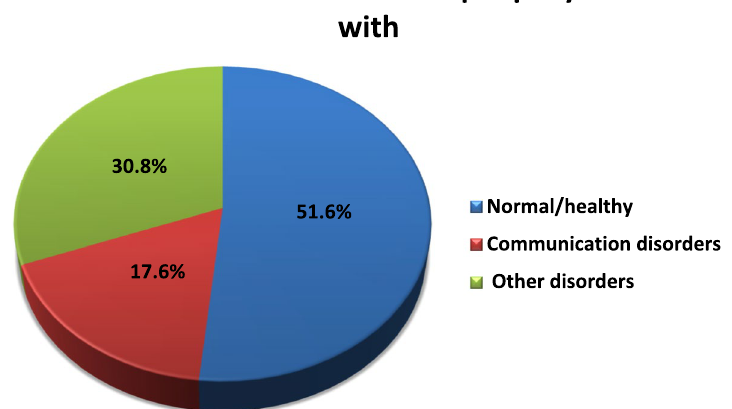
Fig. 3 The main health condition of people the subjects deal with